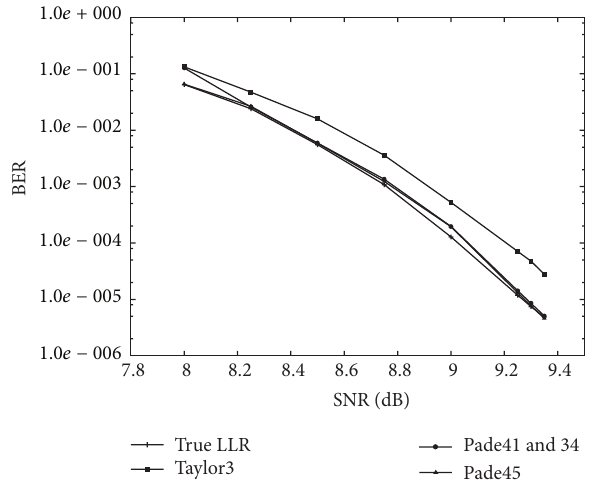
Figure 5: Comparison of BER of (𝑥 2 , 𝑥 3 ) LDPC codes with 𝑁 = 15000 for the uncorrelated flat Rayleigh fading channel with 8-PAM.